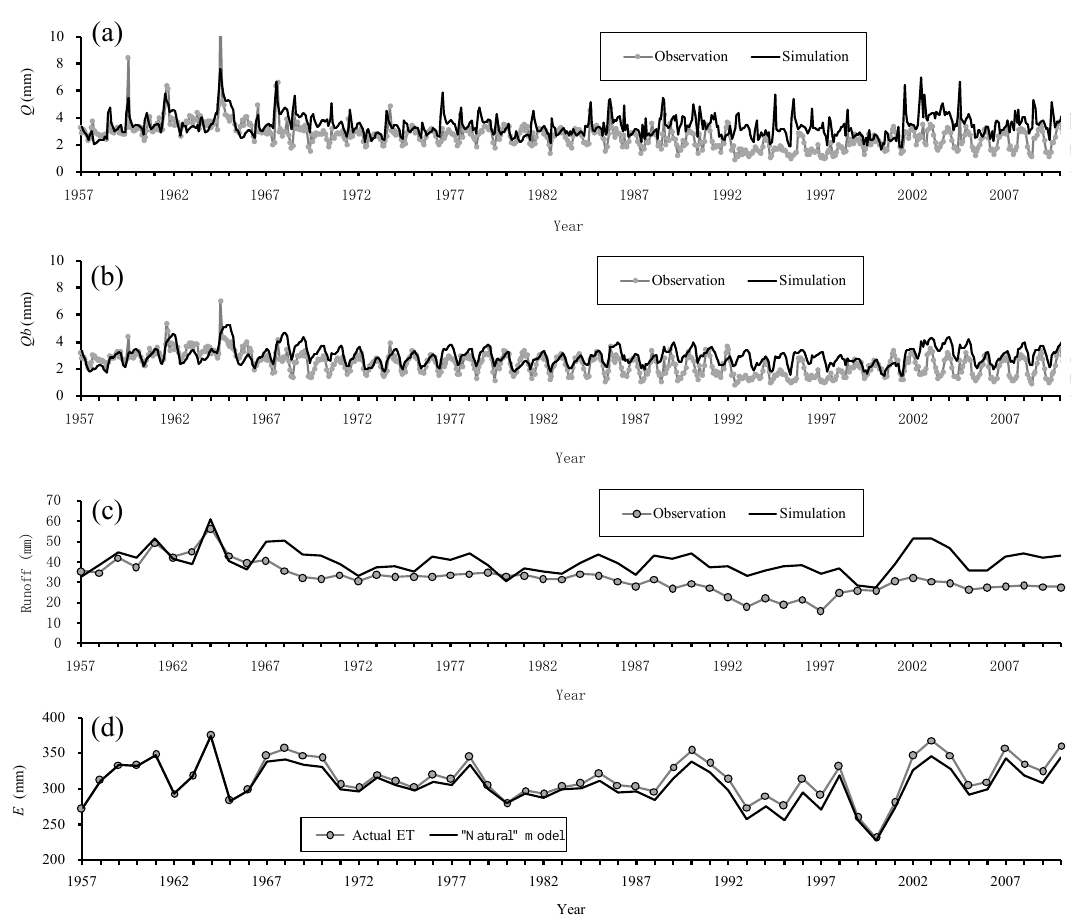
Figure 6. Simulated results of the “natural” ABCD-GE model in comparison with the observation data in catchment C1 from 1957 to 2010, including monthly runoff (a) , groundwater discharge (b) , annual runoff (c) and annual evapotranspiration (d) . The actual evapotranspiration in (d) was estimated with Eq.